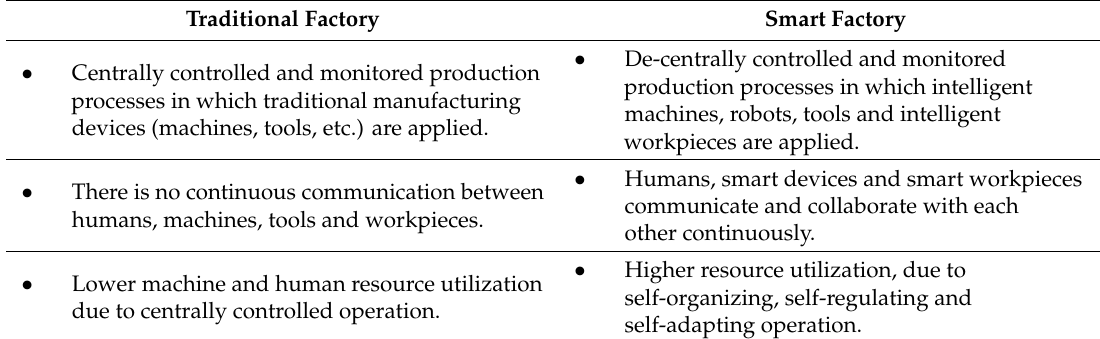
Table 1. Comparison of the traditional factory and Smart Factory. Traditional Factory Smart